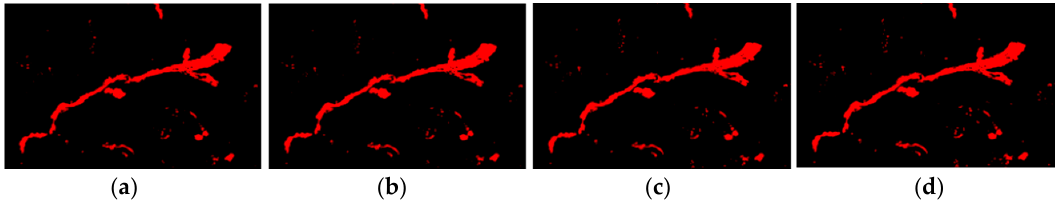
Figure 8. Candidate landslides of Figure 1b using four groups of clustering centers in Table 1: ( a ) candidate landslide using clustering centers shown in Table 1a, ( b ) candidate landslide using clustering